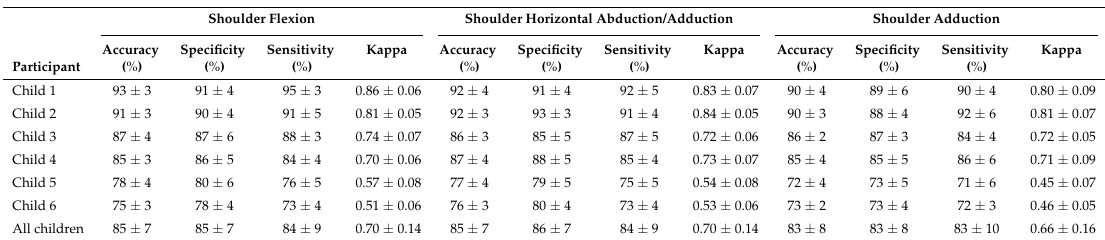
Table 3. The mean ± standard deviation accuracy, specificity, sensitivity, and kappa coefficient values obtained by the computerized assessment method for the six cerebral palsy